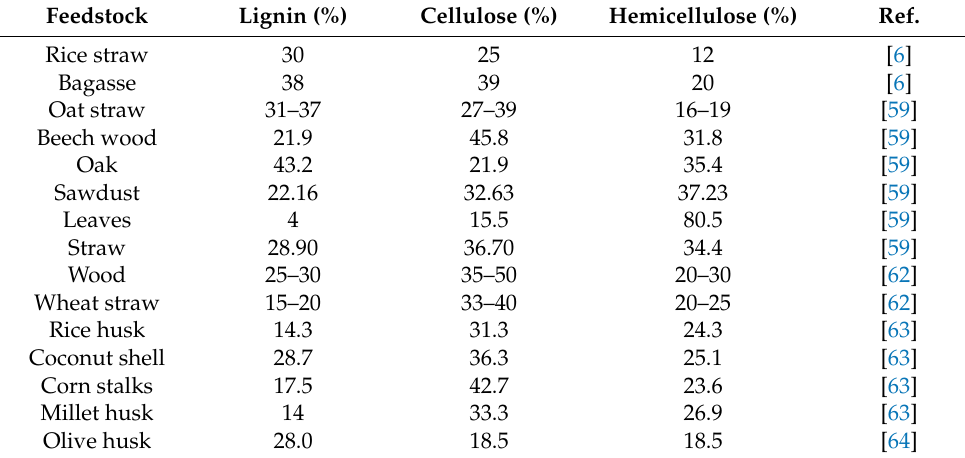
Table 6. Lignin, cellulose, and hemicellulose content in